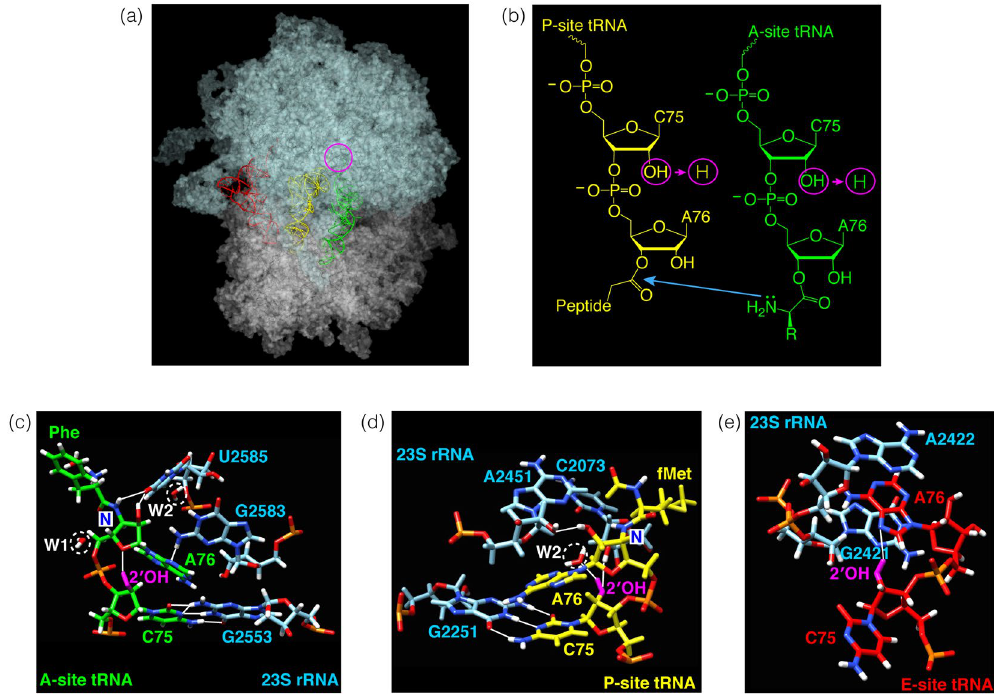
Figure 1. Interactions of the tRNA C75 2 ′ OH in ribosomal A-, P- and E-sites in crystal structures. ( a ) tRNA substrates at the aminoacyl (green), peptidyl (yellow) and exit (red) sites on the 70S ribosome in 3 dimensions. The PTC is circled. ( b ) Two-dimensional chemical structures showing the covalent bonds separating the C75 2 ′ OH groups (circled) from the nucleophile and electrophile of the peptidyl transfer reaction (blue arrow). ( c–e ) Crystal structures of the A-, P- and E-site tRNA substrates, respectively. Models were constructed with UCSF Chimera and PDB file 1VY4 18 . In the original PDB file, three water molecules found within the PTC were proposed to be essential for forming a “proton wire” to couple AA-tRNA accommodation and peptide bond formation. Two of these water molecules are ringed with white dashed circles and labeled W1 and W2 (W3 is not visible in this view). H-bonds are shown with white thin lines. ( c ) A-site Phe-tRNA Phe in green, with the 2 ′ OH in magenta. C75 forms a Watson-Crick base pair with G2553 of 23S rRNA, and the 2 ′ OH of C75 forms an H bond with the O4 of the A76 sugar pucker. N indicates that Phe was linked to the tRNA with an amide bond. ( d ) P-site fMet-tRNA fMet in yellow, with the 2 ′ OH in magenta. C75 forms a Watson-Crick base pair with G2251 of 23S rRNA, and the 2 ′ OH of C75 forms H bonds with W2 and the 2 ′ OH of ribose C2073 of 23S rRNA. N indicates that fMet was linked to the tRNA with an amide bond. ( e ) E-site tRNA Phe in red, with the 2 ′ OH in magenta. C75 does not form a base pair, whereas the 2 ′ OH of C75 forms an H-bond with the N7 of the base of A76 in the same